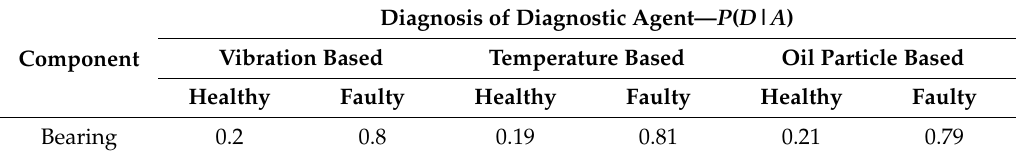
Table 2. Diagnosis matrix of the main bearing of the wind turbine discussed in this case study.